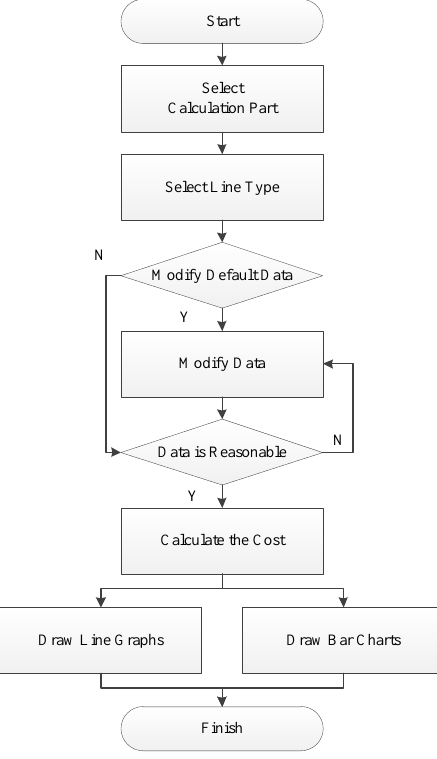
Figure 5. Flow chart of the software.